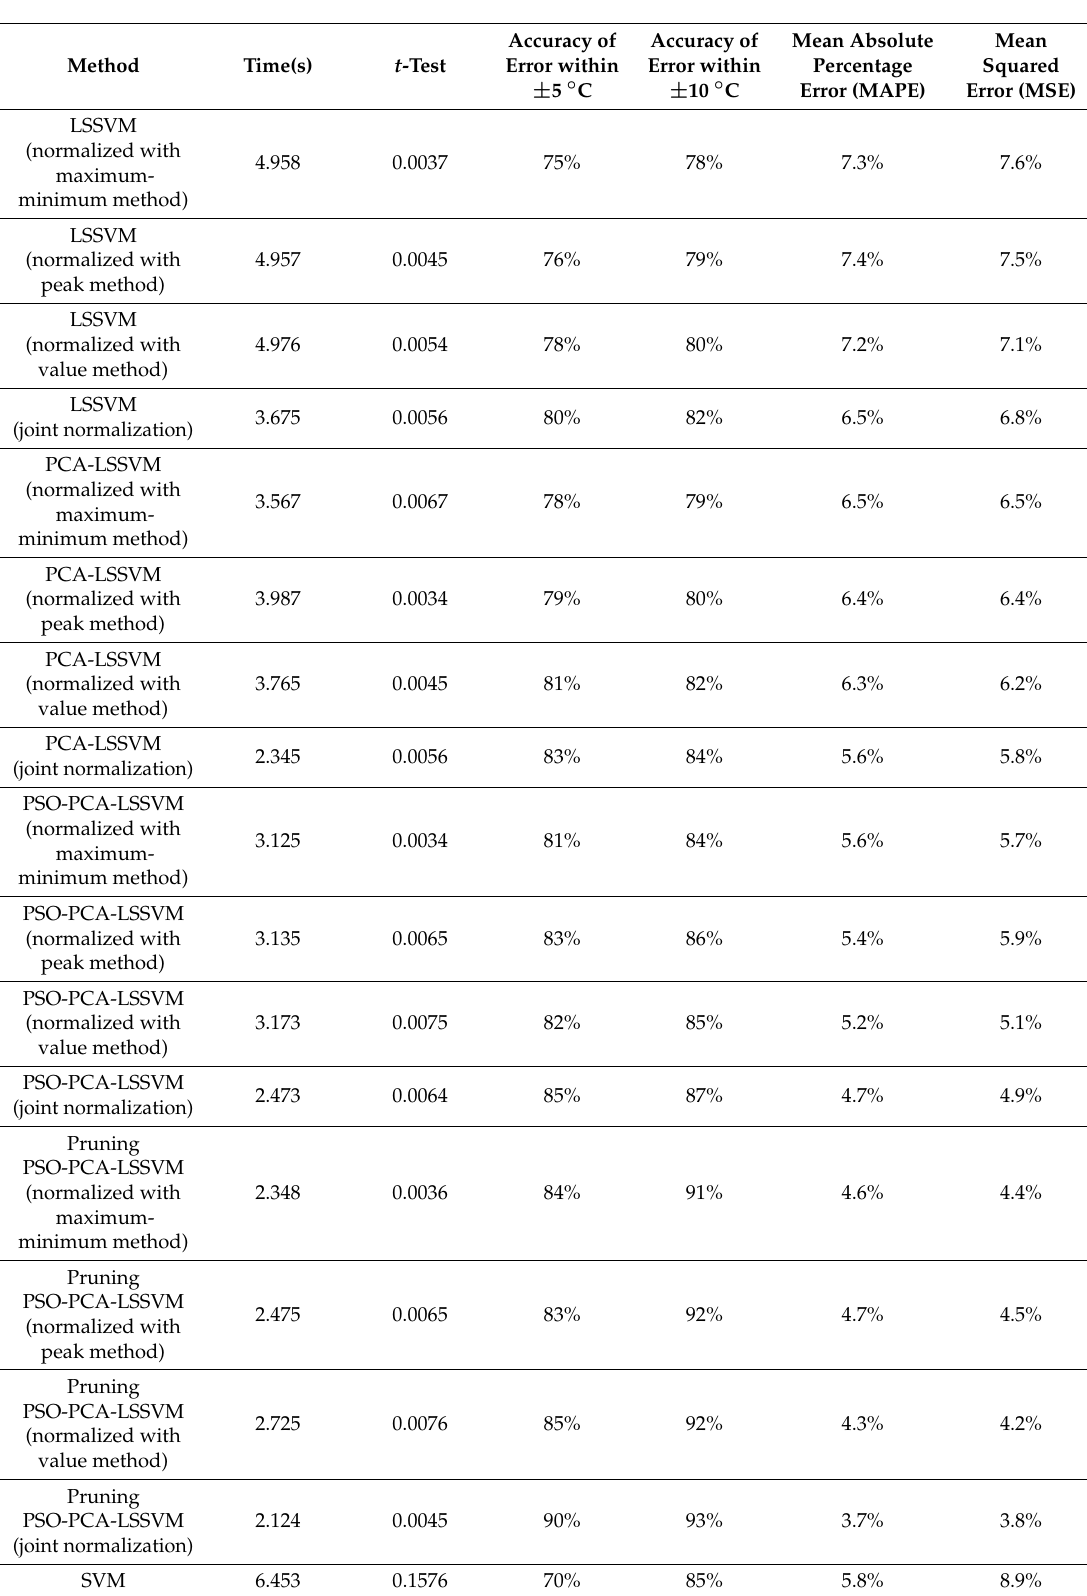
Table 5. Comparison of various algorithm